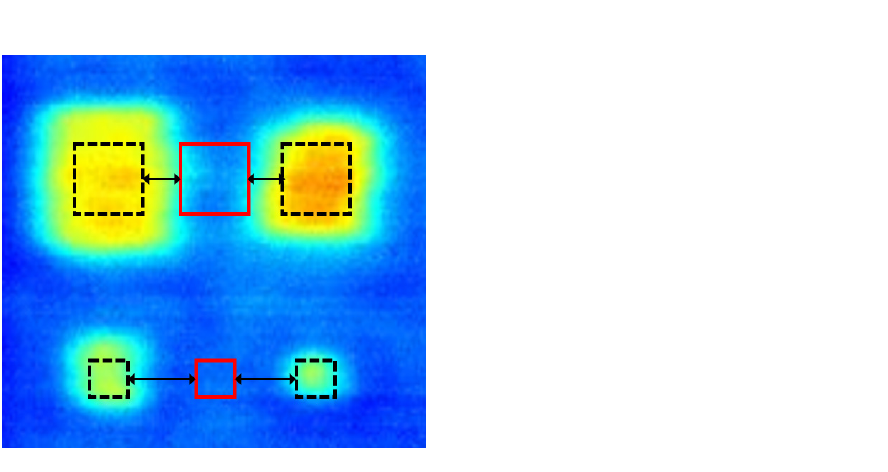
Figure 6. Representation of selected areas for contrast and CNR computation. The black dashed line enclosed area represents the water ingress areas and the red solid line enclosed area represents the sound areas.